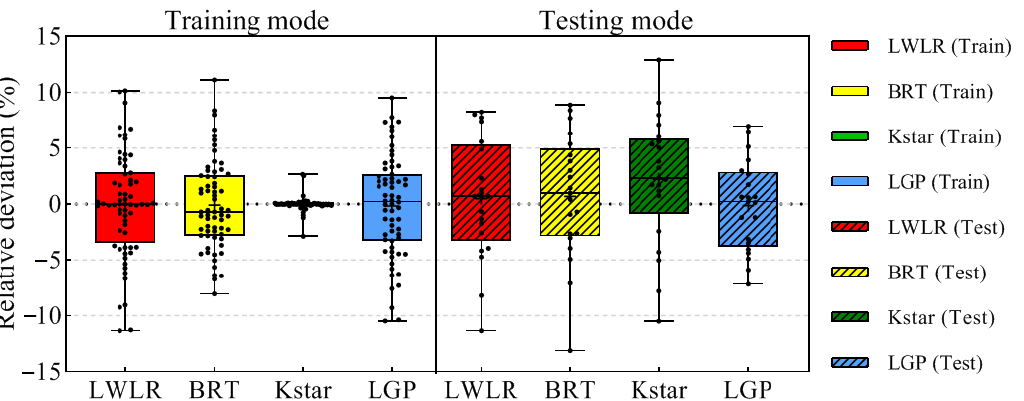
Figure 10. Box plots for the relative deviation (%) distribution of all predictive models in testing and training.